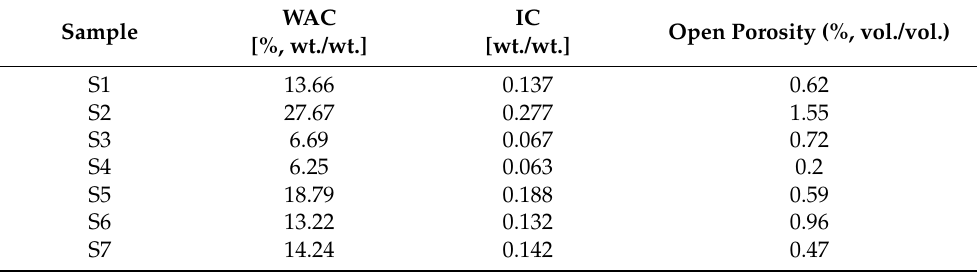
Figure 7. Raman spectra of clinker bricks. ( a ) S1–S3; ( b ) S4–S7.